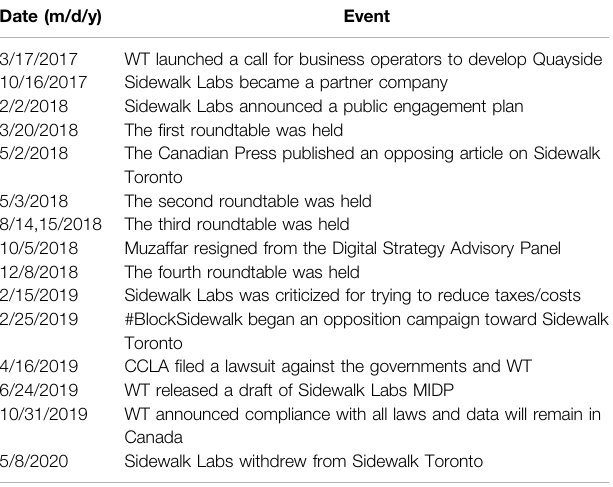
TABLE 1 | Summary timeline of the Sidewalk Toronto